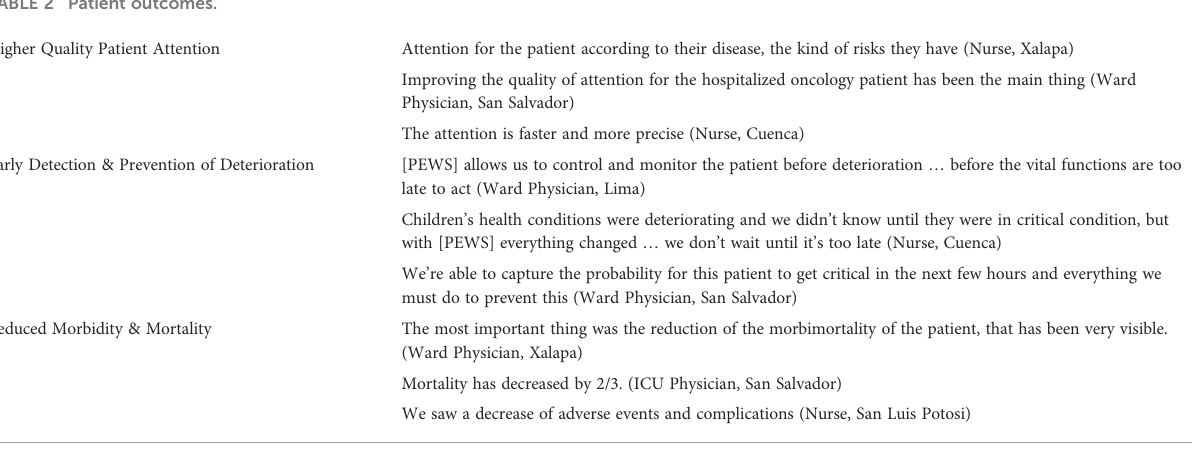
TABLE 2 Patient